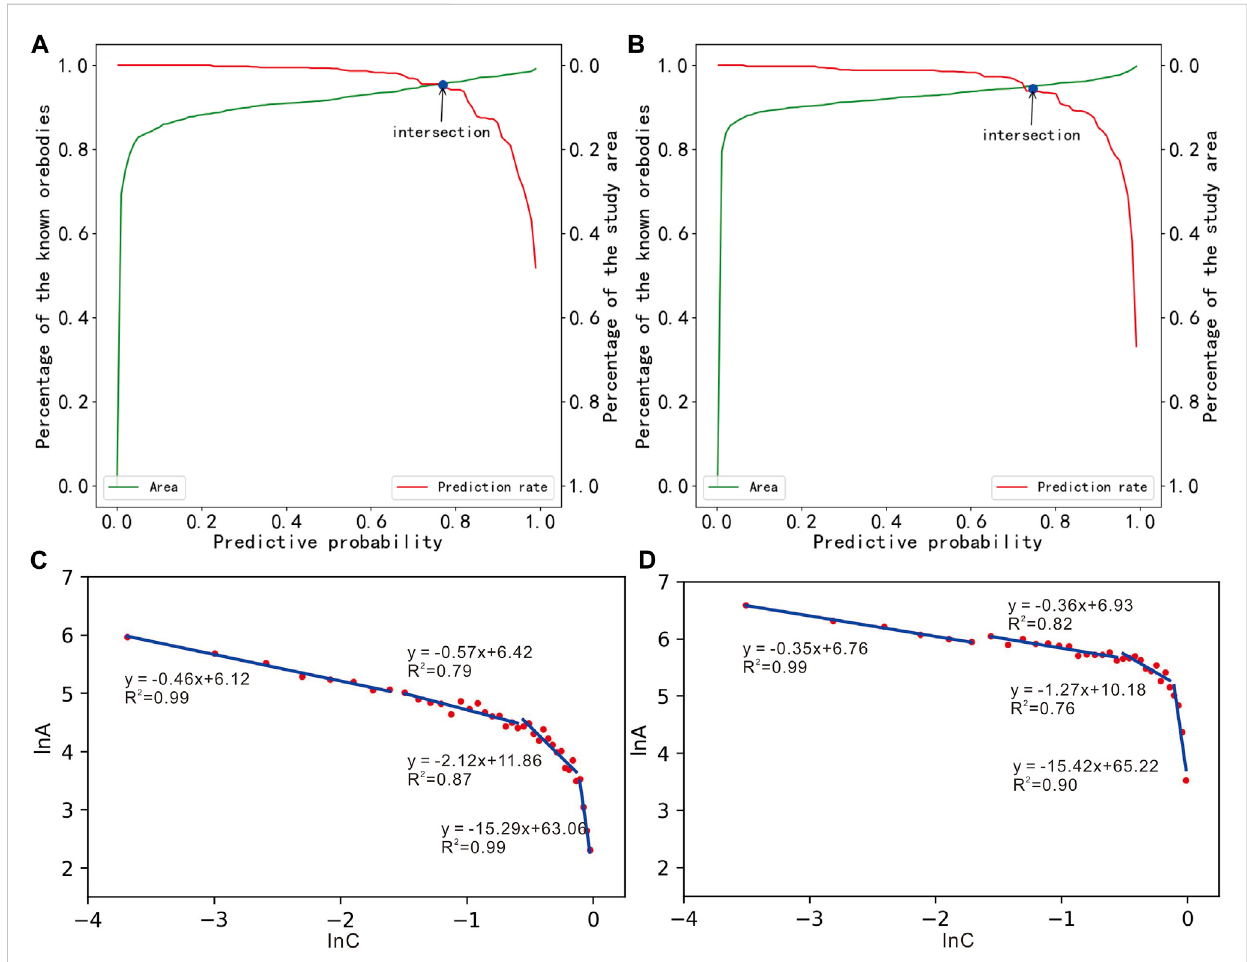
FIGURE 11 P-A plot of (A) RF28; (B) XGBoost11. C-A fractal of (C) RF28 (D)